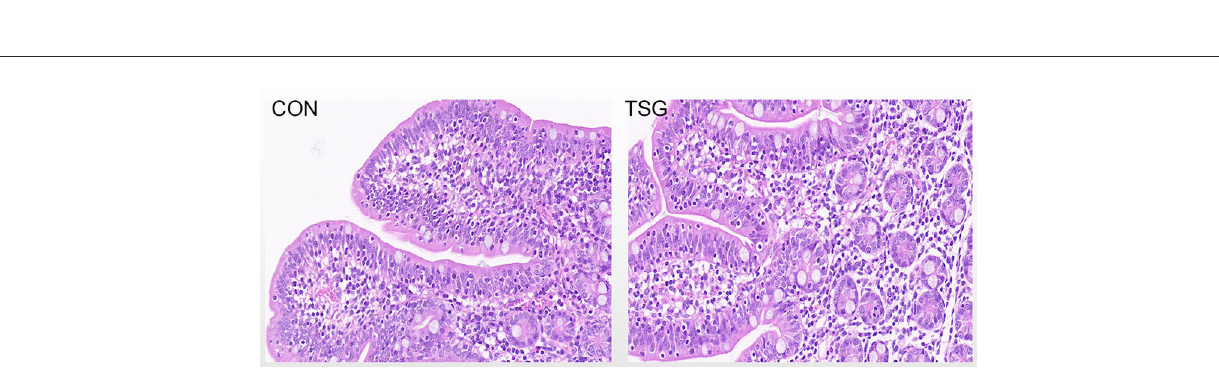
transcriptome sequencing. As shown in the volcano plot and bar chart, a total of 816 DEGs were identified between the two groups, of which 632 genes were upregulated and 184 genes were downregulated in the TSG group (Figures 5A,